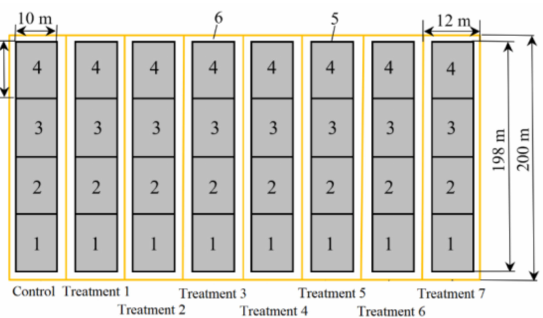
Figure 1. Experimental design of field research: 1, 2, 3, 4—repetitions; 5—accounting field; 6— protection zone.